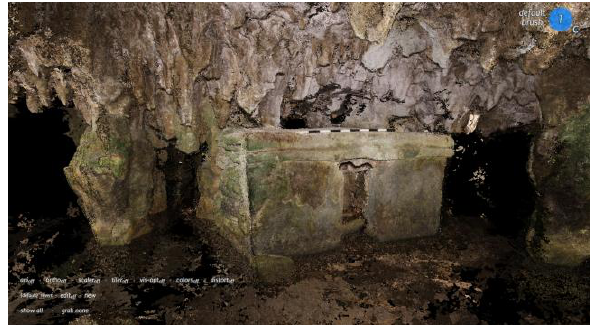
Figure 2. Point cloud (via SfM photogrammetry) of the shrine in the cave known as “Aluxes.”